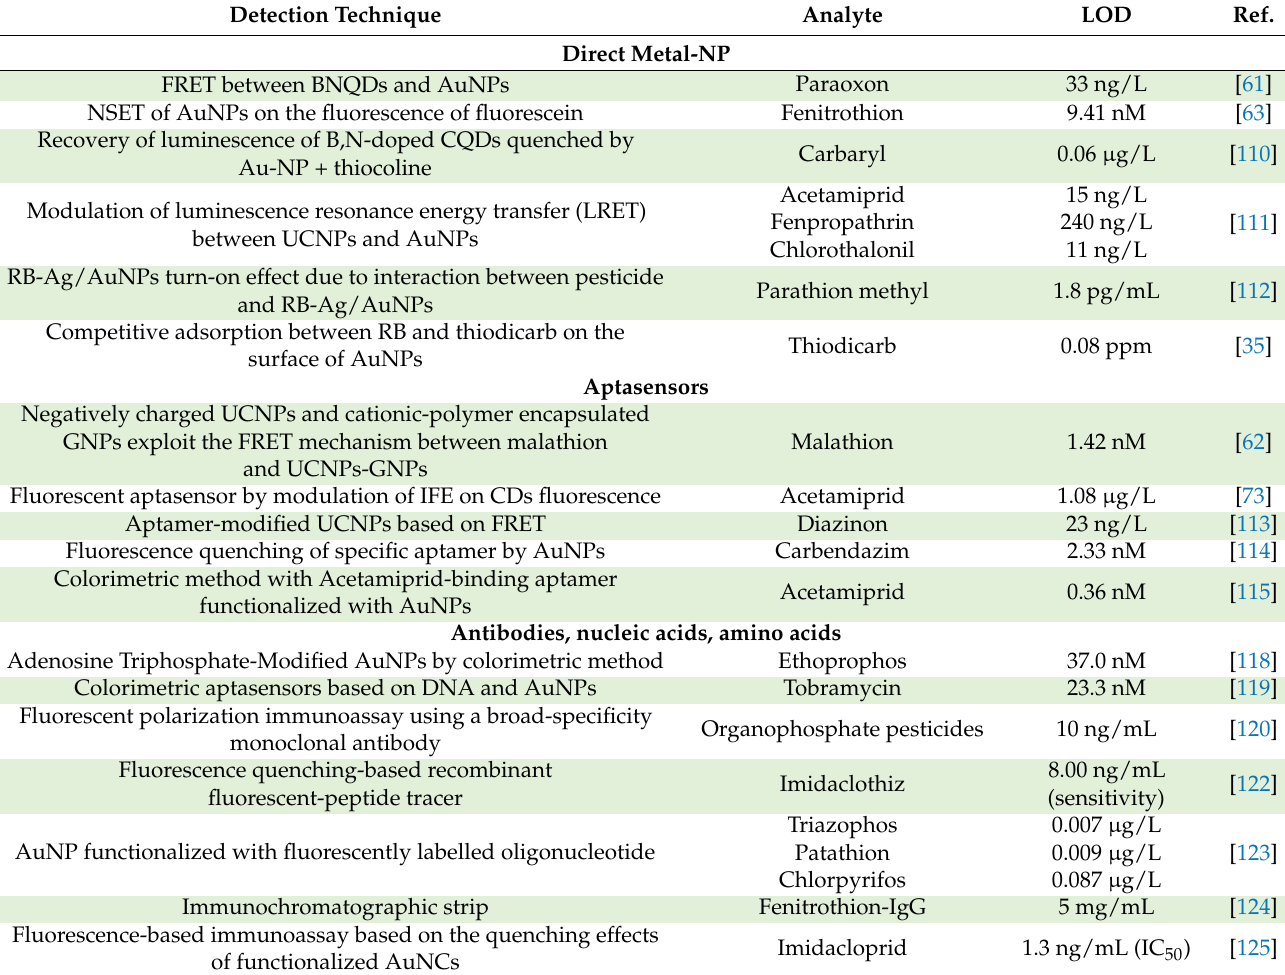
Table 4. List of metal nanomaterials for pesticides detection with the interaction mechanisms and the LOD values. Detection Technique